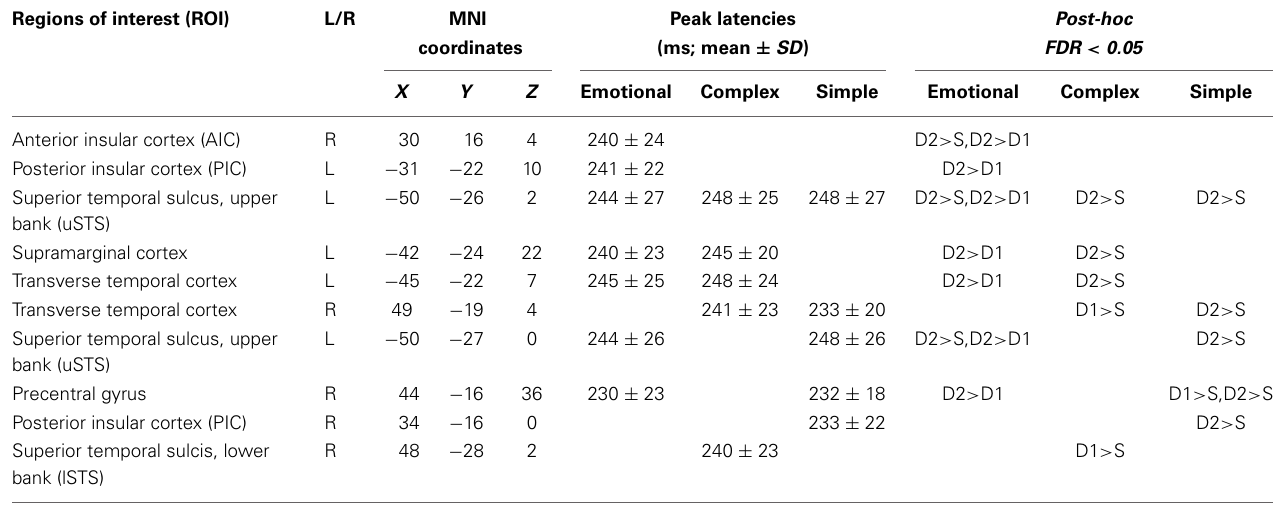
Table 2 | MMNm-related cortical